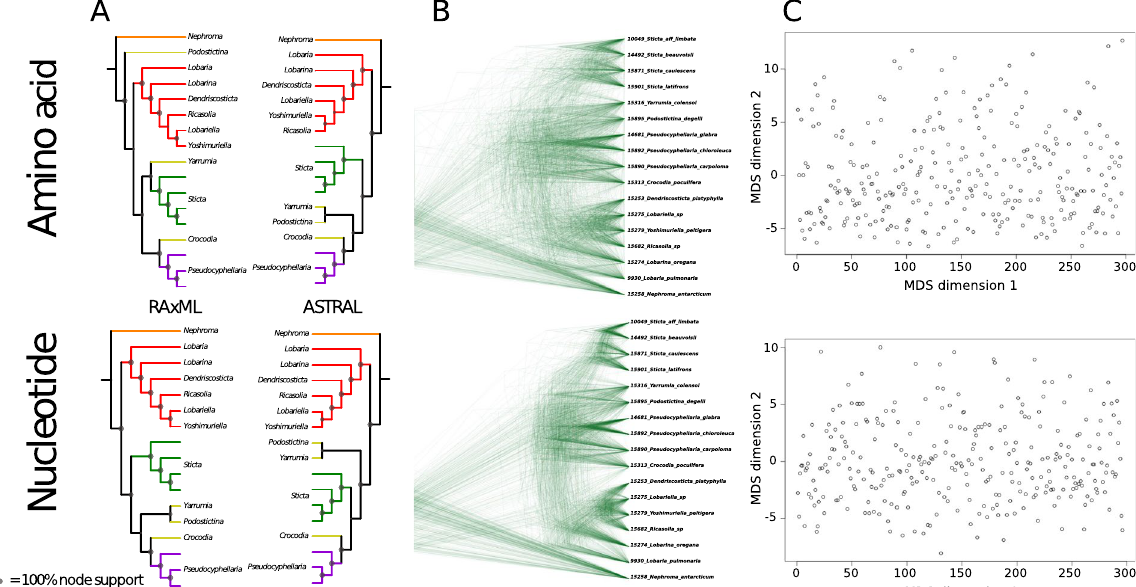
Figure 3. Poor support, incongruence of relationships of genera and gene tree discordance in Lobariaceae with ( A ) different methods (RAxML vs. ASTRAL) and different datatypes (amino acid vs. nucleotide) of the reduced dataset of 297 loci and 17 tips with no missing data. Nodal support is depicted by the size of the gray circles in the nodes, with larger circles being higher supported. ( B ) DensiTree plots of the gene trees used to produce the 297 × 17 datasets. ( C ) Dimension one of multidimensional scaling (MDS) plots of one-to-one Robinson Foulds distances of 297 trees produced from amino acid and nucleotide